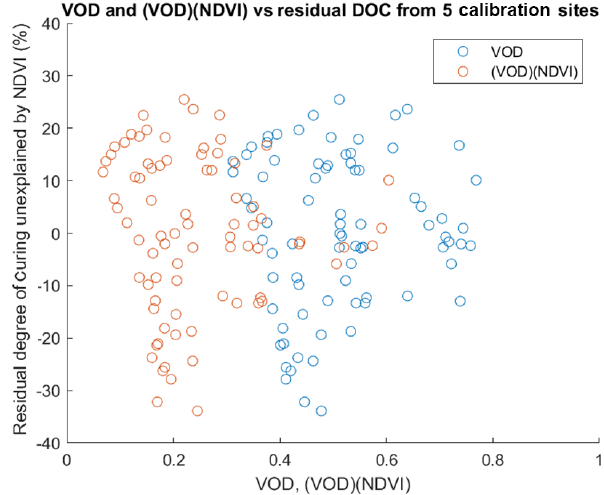
Figure 4. Scatter plot of residual observed degree of curing (DOC) from five calibration sites that are unexplained by NDVI against VOD and combined VOD and NDVI